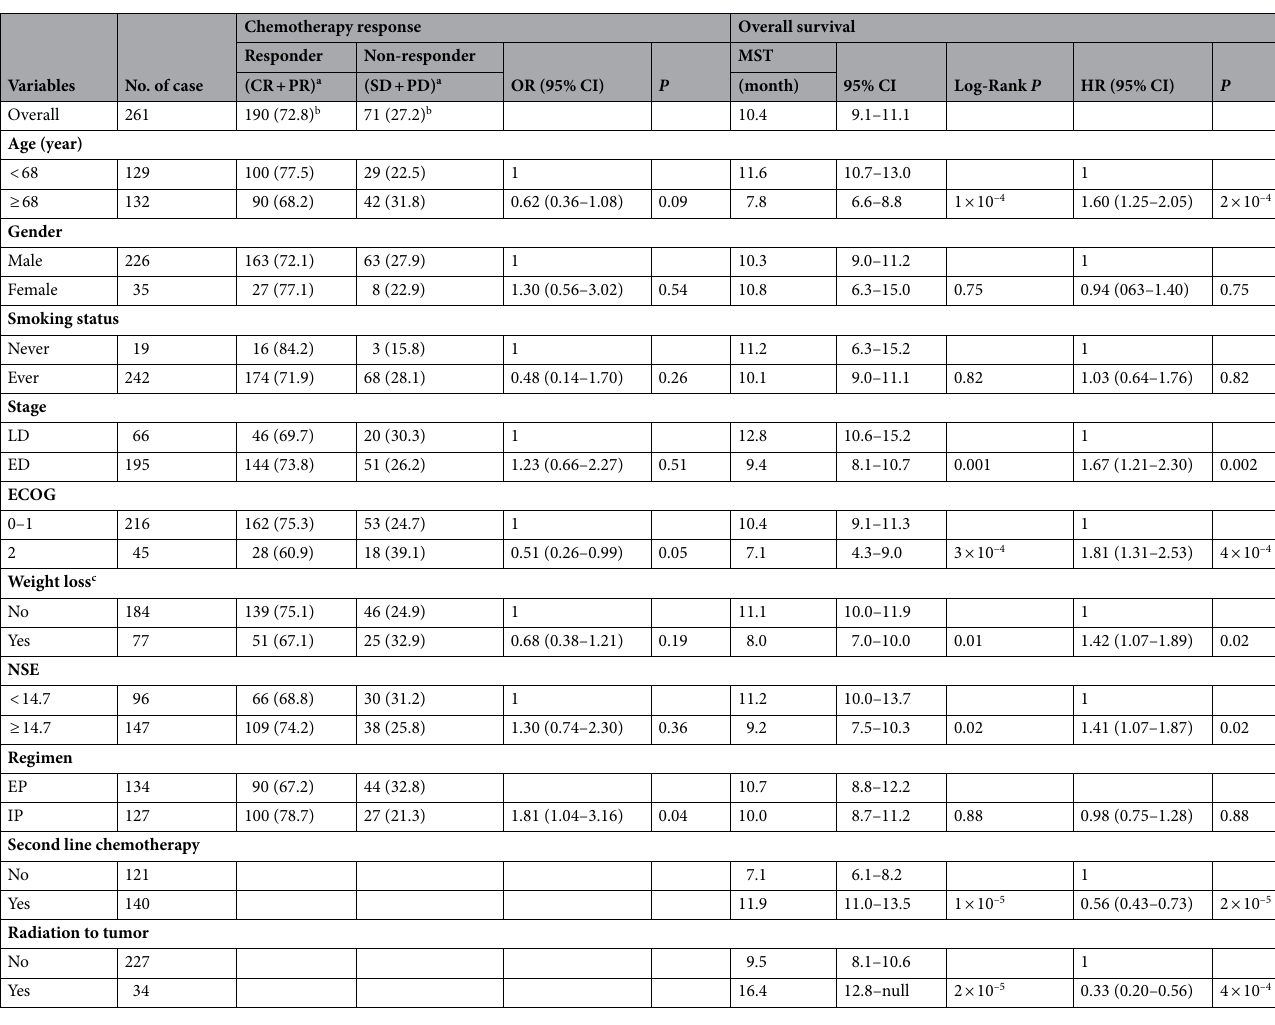
Table 1. Univariate analysis for chemotherapy response and overall survival by clinical variables. CR, complete response; PR, partial response; SD, stable disease; PD, progressive disease; OR, odds ratio; CI, confidence interval; MST, median survival time; HR, hazard ratio; LD, Limited disease; ED, Extensive disease; ECOG, Eastern Cooperative Oncology Group; NSE, neuron specific enolase; EP, etoposide-cisplatin; IP, irinotecan-cisplatin. a Number of patients: 18 CR, 172 PR, 49 SD, and 22 PD. b Row percentage. c Unintentional weight loss > 5% within 3